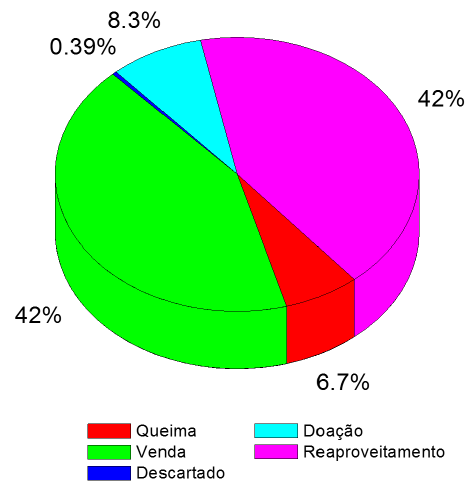
Figure 3. Waste MDF in powder collected in a joinery. Souce: Adapted based on Koch 6